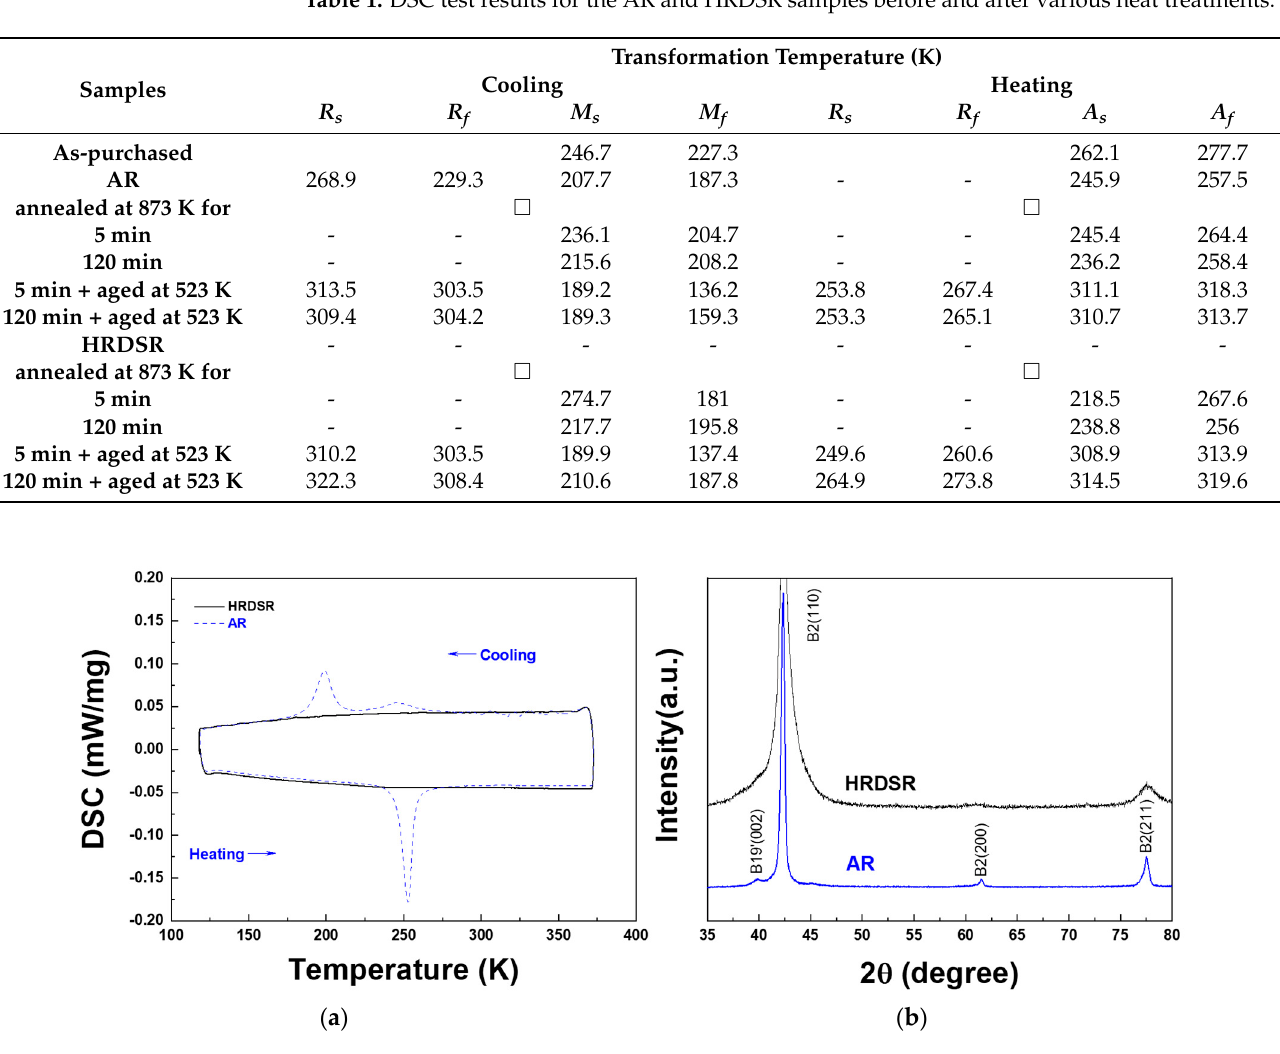
Figure 2. ( a ) The DSC curve for the AR and HRDSR samples. ( b ) The XRD curves for the AR and HRDSR samples. Identification of phases was made based on the data from JCPDF cards (01 − 076 − 3614, 01 − 076 − 7519 and 01 − 076 − 4263). Figure 2b shows the XRD curves for the AR and HRDSR samples, respectively. For both samples, only the B2 austenite phase is identified, which agrees with the prediction from the DSC result. Compared to the AR sample, the HRDSR sample has considerably broader peaks, indicating that the dislocation density and the ratio of amorphous and nanosized grains are greatly increased after SPD by Table 1. DSC test results for the AR and HRDSR samples before and after various heat treatments.